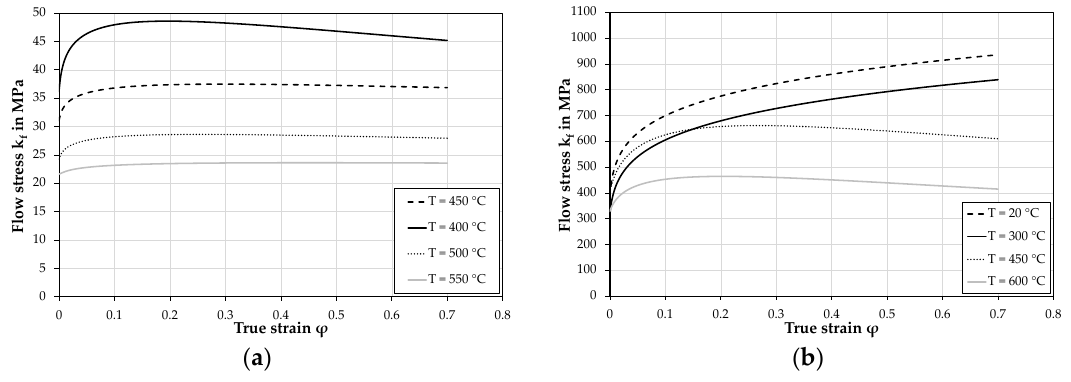
Figure 5. Flow curves at a strain rate of 1 s −1 for various temperatures of ( a ) EN AW-6082 and ( b ) 20MnCr5.